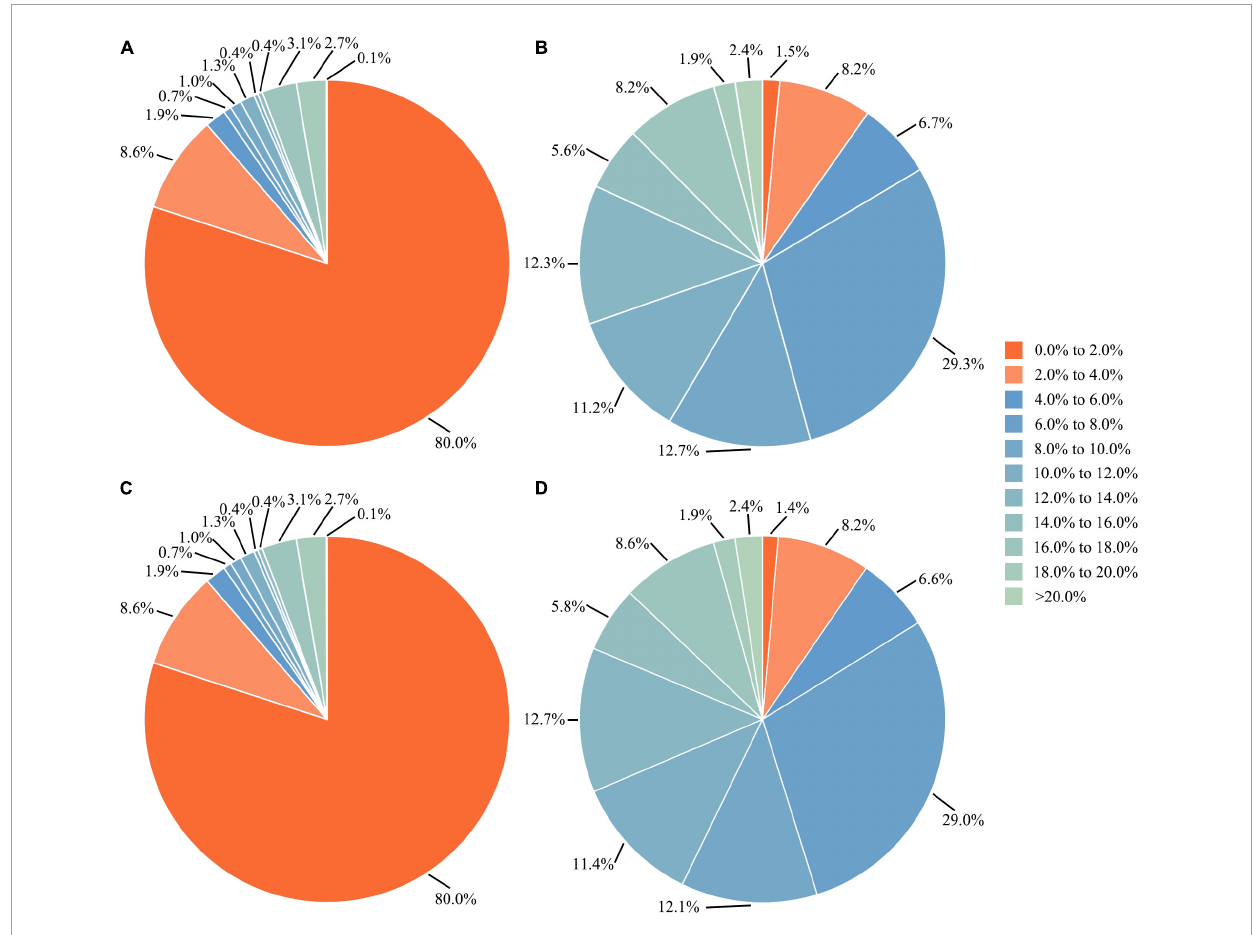
FIGURE4 Proportions of (A,C) intra- and (B,D) interspecific genetic distances based on the complete dataset and the dataset excluding species with less than five sequences,